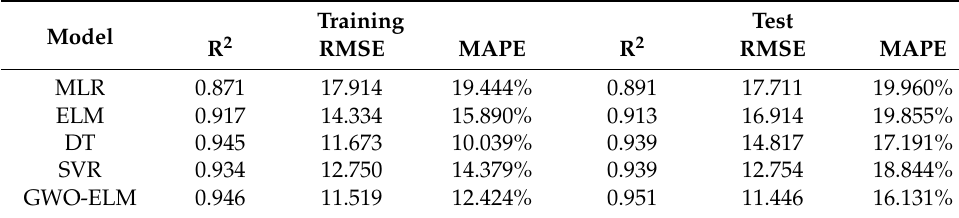
Figure 9. Box plot of relative error for UCS. Table 2. Evaluation index of different models for UCS.